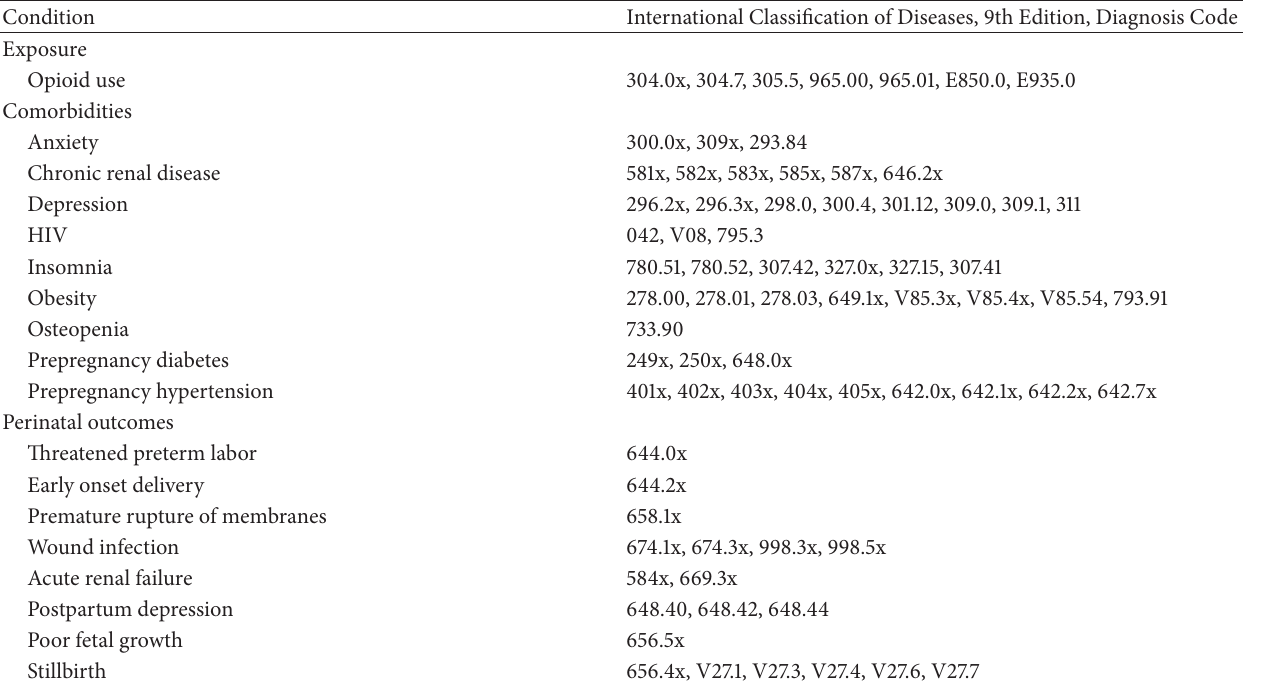
Table 3: List of International Classification of Diseases, Ninth Edition, Clinical Modification Codes used to identify selected perinatal